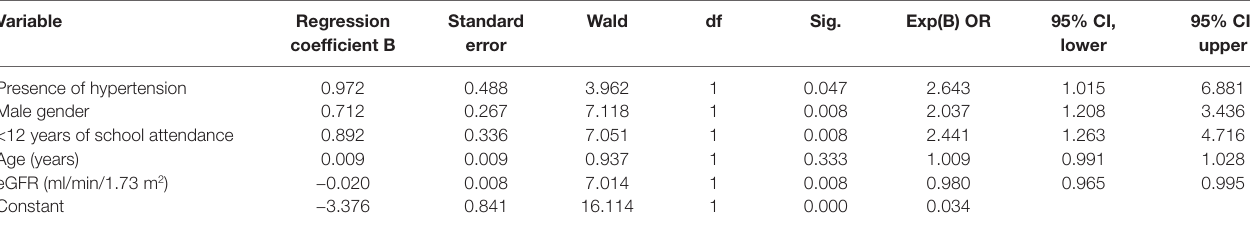
TaBle 3 | Binary logistic regression analysis with DemTect (dichotomous) as the dependent variable and variables that were significant in the univariate tests as the independent variable (n = 552). Variable Regression Standard coefficient B